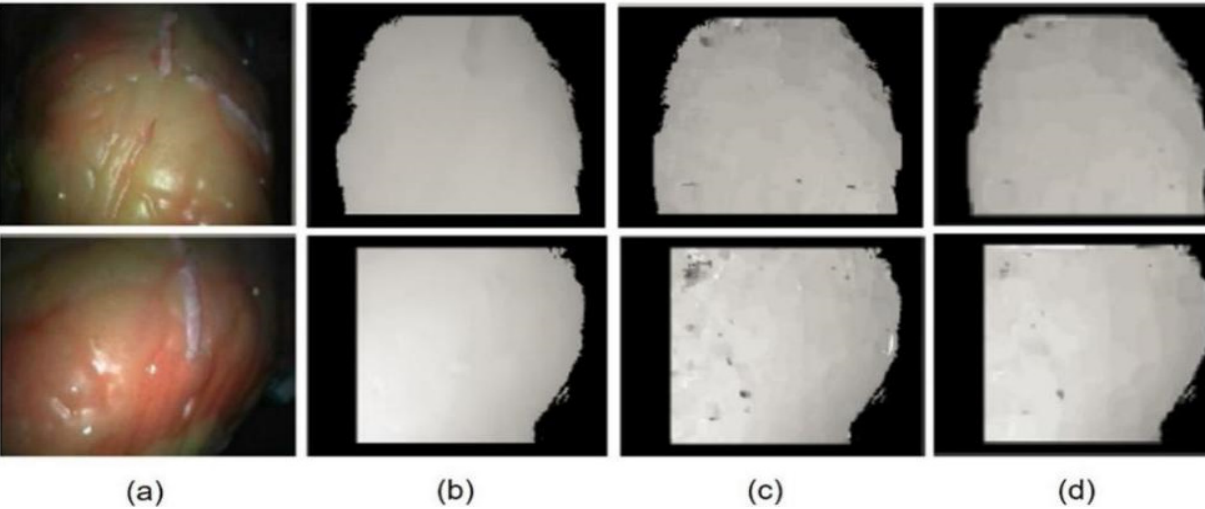
Figure 5. The corresponding matching results of the joint similarity measure before and after the improvement. ( a , b ) standard parallax map; ( c ) The improved joint similarity measure corresponds to the disparity map; ( d ) the improved joint similarity measure corresponds to the disparity map. Table 2. Corresponding mismatching rate of joint similarity measure before and after improvement.